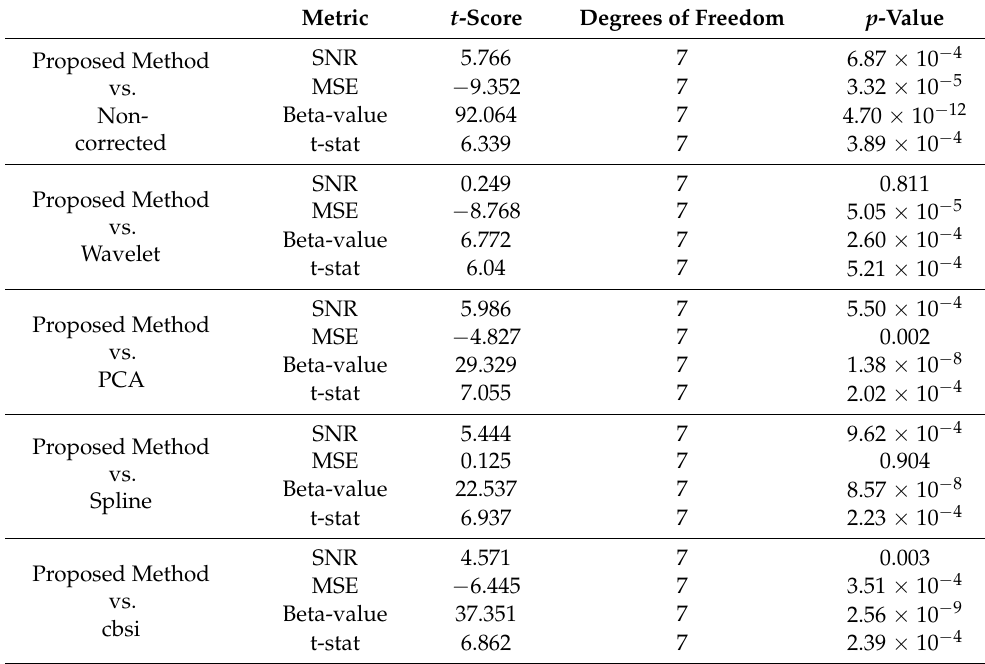
Table 1. Paired t -test results (method proposed vs. non-corrected signal) associated to the metrics used to investigate the method’s performance, evaluated for the channels averaging all the